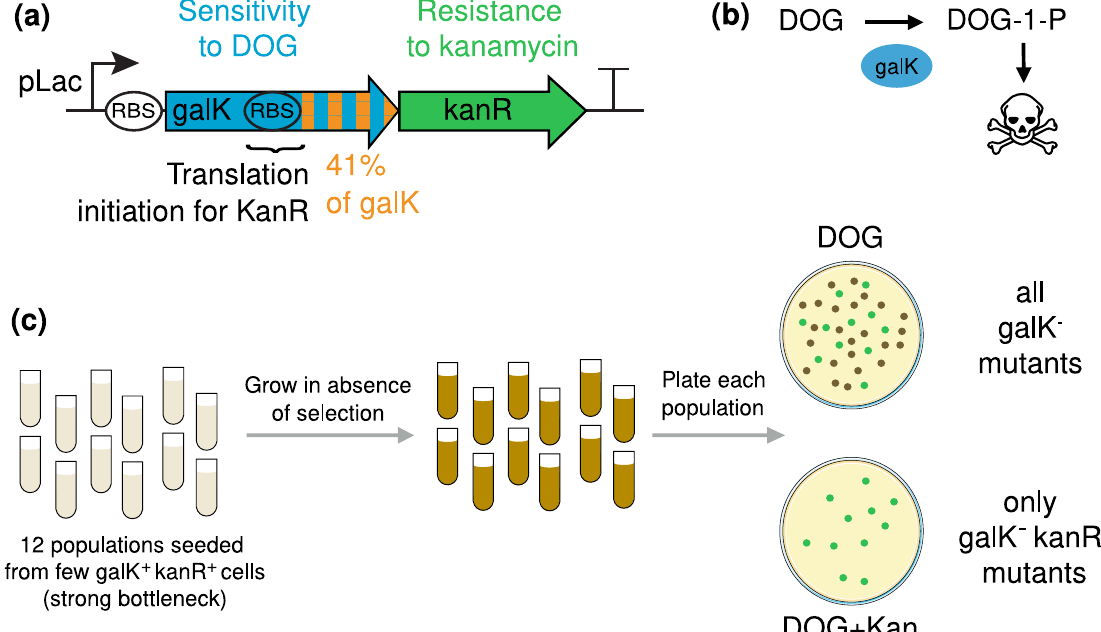
Fig 4. Synthesized construct and experimental design. (a) Synthetic construct: overlapping reading frame between galK, which confers sensitivity to DOG, and kanR, which confers resistance to kanamycin. The expression of both genes is controlled by the pLac promoter: in absence of the IPTG inducer, the operon is repressed by lacI q . (b) galK metabolises DOG into a toxic compound (see S4 Fig for more details). (c) Experimental design: random mutations appear during growth in absence of selection and are subsequently scored by plating on selective medium. This design permits to test whether purifying selection applied on kanR (presence of kanamcyin) protects galK from loss- of-function mutations.